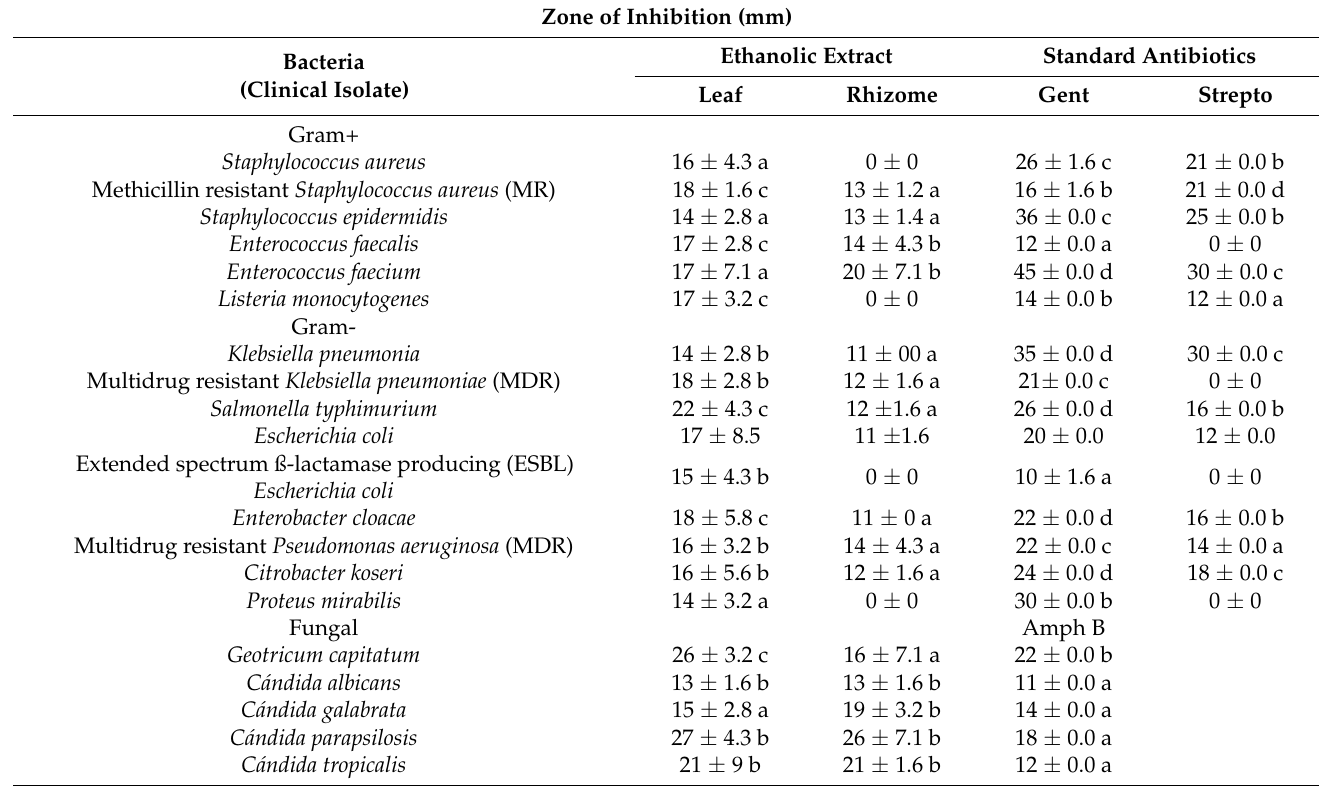
Table 4. Antibacterial and antifungal activities of leaf and rhizome ethanol extracts of A. acutifolius.